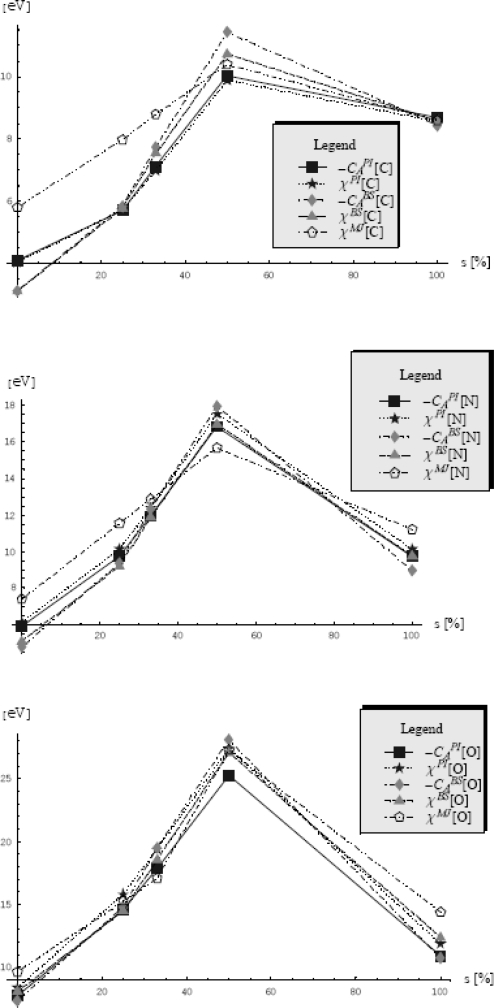
From top to bottom, the representations of the orbital electronegativities and of the absolute chemical actions for C, N and O atoms versus the different percent contribution of s orbital (p: 0%, sp3: 25%, sp2: 33%, sp: 50% and s: 100%) in pseudo-potentials and basis set frameworks of electronic densities computation with path integral (PI), basis set (BS), and Mulliken-Jaffe (MJ) results of Table 5.